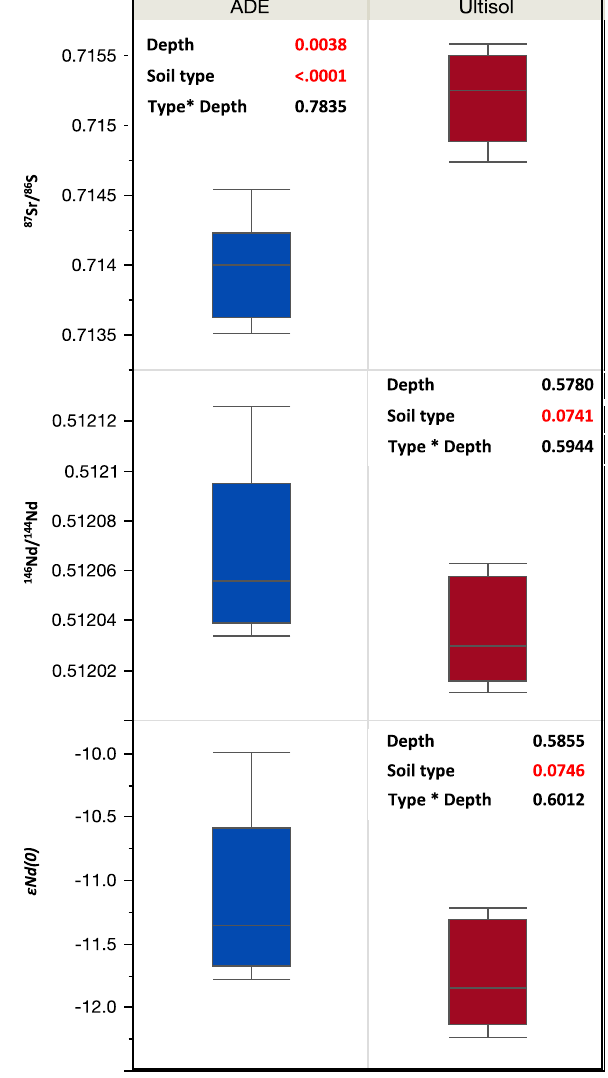
Fig. 6 Isotope ratios of strontium (Sr), neodymium (Nd), and radiogenic epsilon neodymium ( ε Nd (0)). The box plots show 25th, 50th, and 75th percentiles and the error bars show the data range ( n = 8 for ADE and n = 5 for Ultisol). In all cases, a two-way analysis of variance shows signi fi cant differences between soil